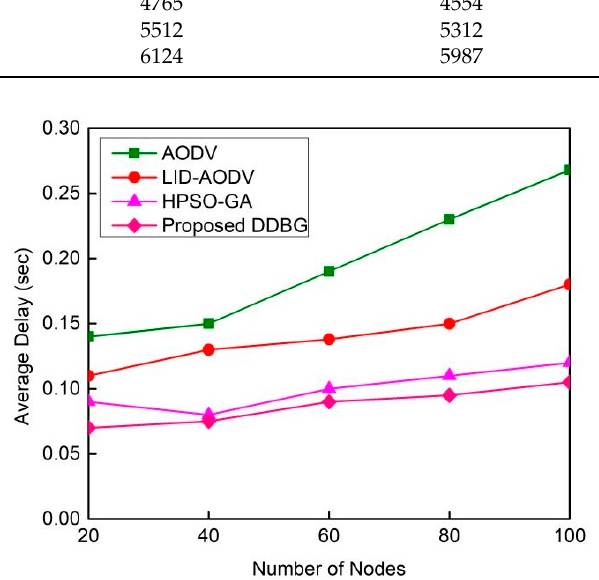
Figure 8. The average delay (s). Table 8. The average delay(s).evaluation values.